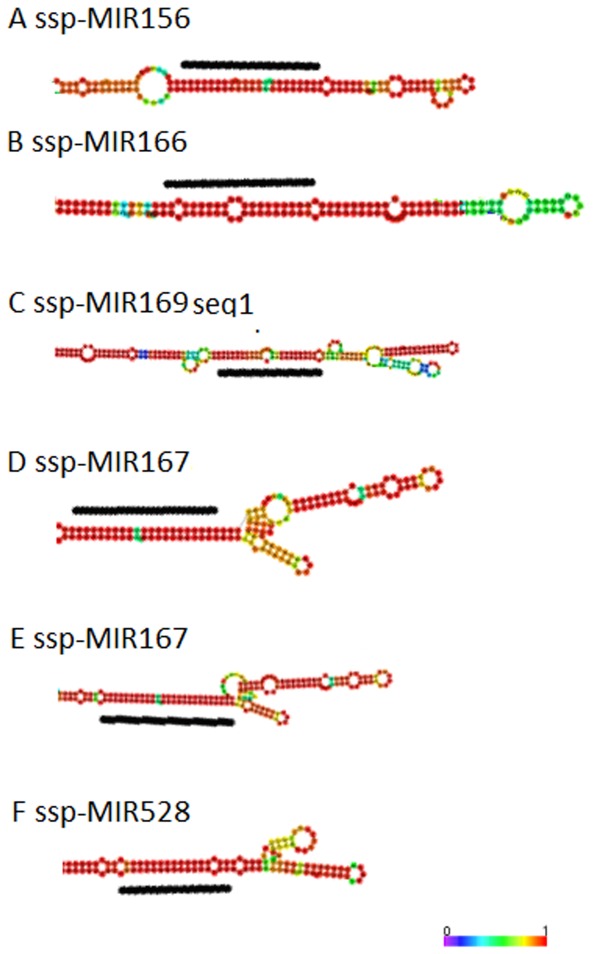
Primary transcripts containing the predicted stem-loop structures of the precursors of the sugarcane miRNAs.The mature miRNAs identified in the sugarcane sRNA library are highlighted in black. The sizes of the precursors may be slightly longer than represented. The colors represent the probabilities for sequence alignment. Red is the highest probability of alignment (1), and purple is the lowest probability of alignment (0).